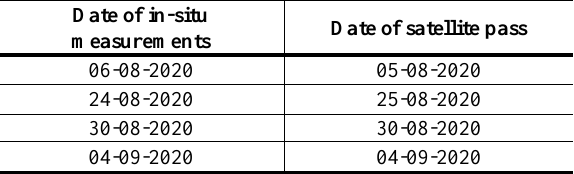
Table 2. The dates of in-situ measurements and Sentinel-2 acquisitions.